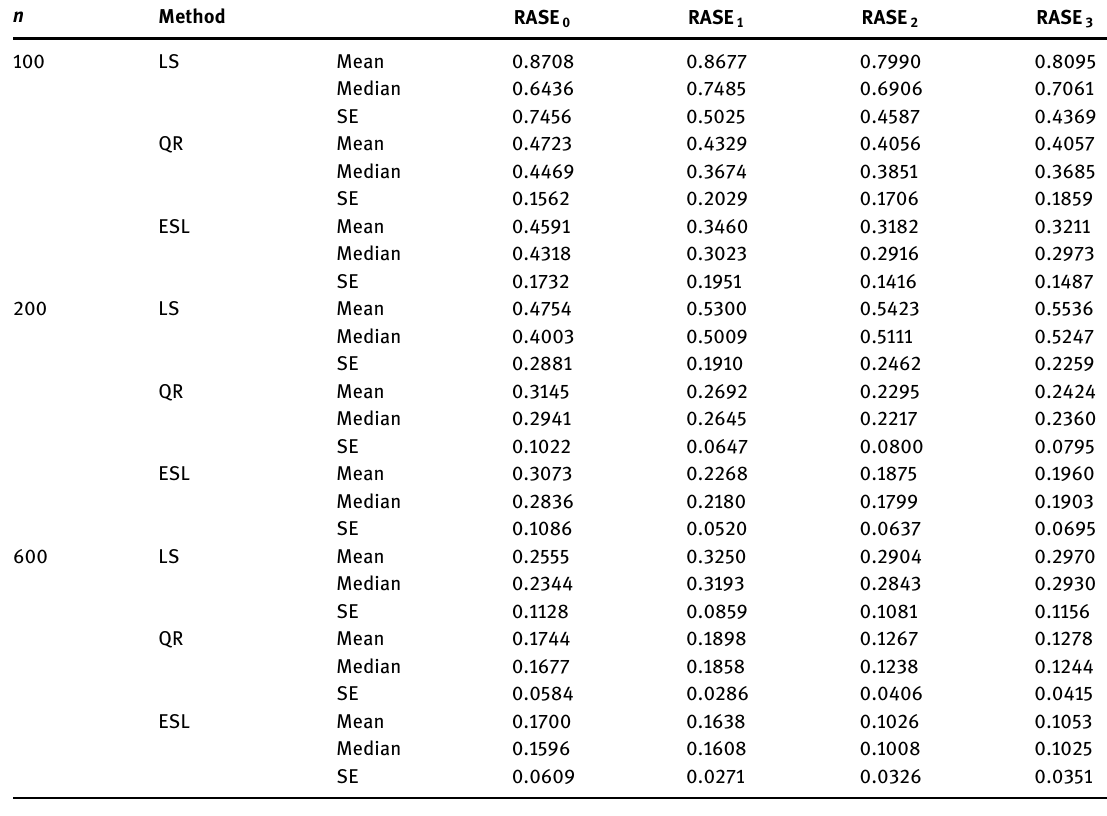
Table 3: Simulation results for comparison